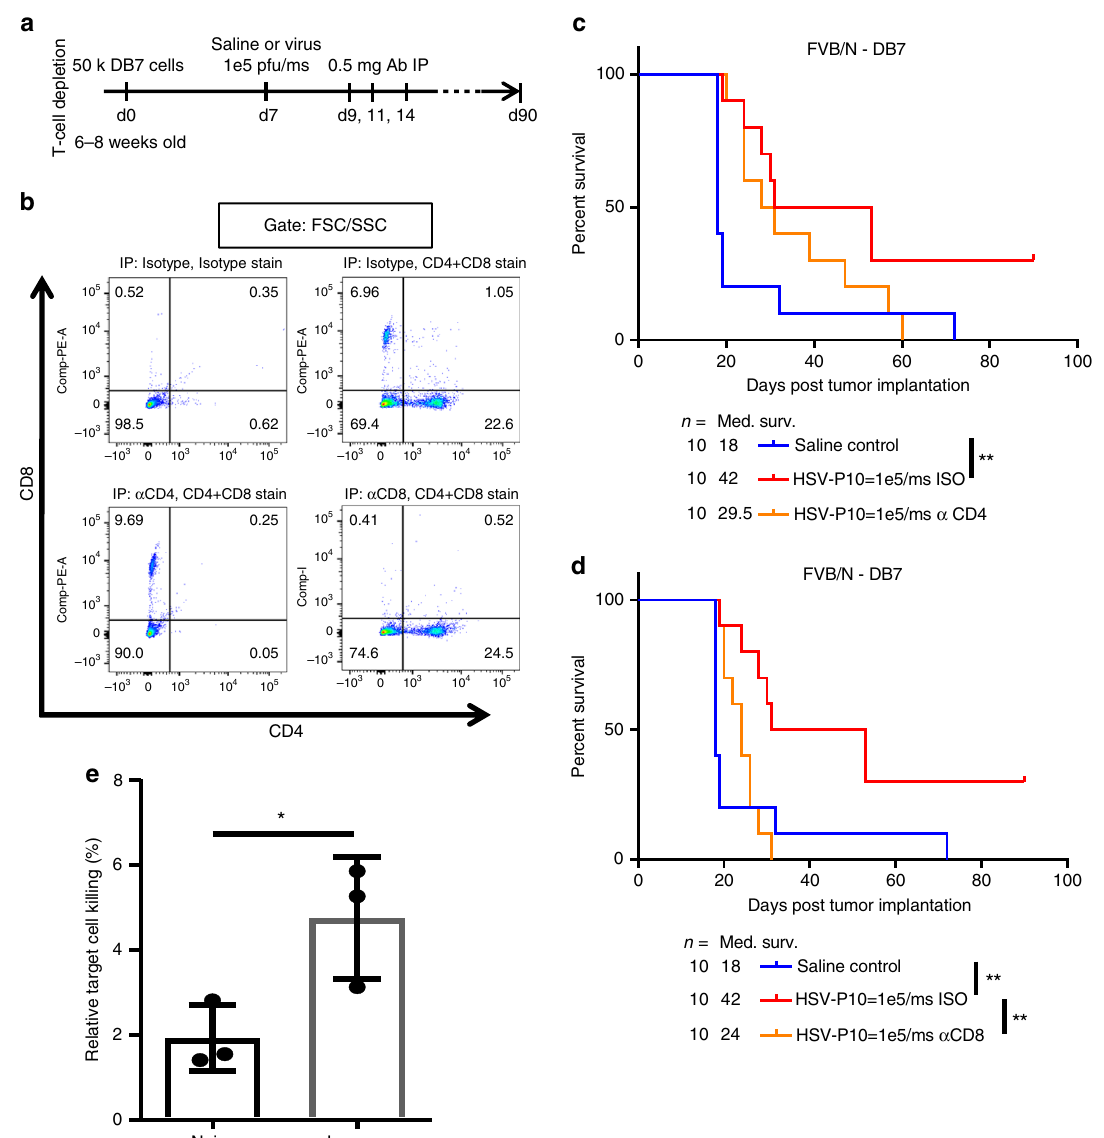
Fig. 9 Role for T-cell immunity in virus-mediated tumor clearance. a Schematic representation of T-cell depletion study. b Con fi rmation of T-cell depletion by IP anti-CD4, anti-CD8, or isotype treatment 24 h prior to harvesting. Splenocytes were isolated 24 h after IP administration of anti-T-cell depletion antibodies in naïve FVB/N mice, and probed for CD3 + , CD4 + , and CD8 + T-cells as measured by fl ow cytometry. Live spenocytes were gated using forward and side scatter, and then gated on CD4-FITC and CD8-PE. Single-color positive quadrants (Q1 for CD8 + and Q3 for CD4 + ) were interrogated to determine depletion. c Survival of DB7 tumor-bearing FVB/N mice treated with saline control or HSV-P10 7 days post tumor cell implantation, and isotype or anti-CD4 antibodies 2, 4, and 7 days post virus injection. Signi fi cance in survival was assessed by Logrank (Mantel – Cox) test ( n = 10, ** p < 0.01). d Survival of DB7 tumor-bearing FVB/N mice treated with saline control or HSV-P10 7 days post tumor cell implantation, and isotype or anti-CD8 antibodies 2, 4, and 7 days post virus injection as indicated. Signi fi cance in survival was assessed by Logrank (Mantel – Cox) test ( n = 10, ** p < 0.01). e 51